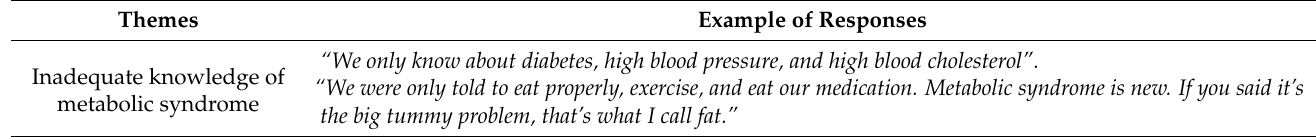
Table 4. Themes derived from responses given by the study respondents (N = 21) in the domain of perceived